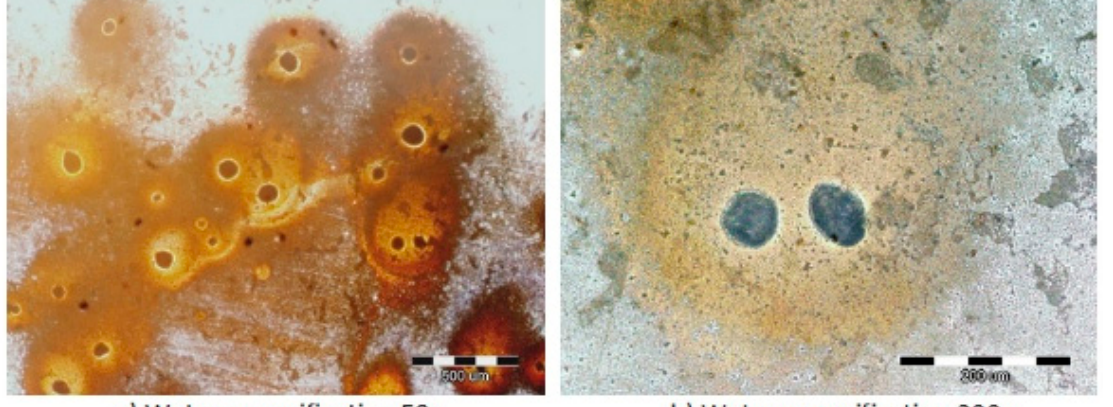
Table 5. EDS analysis of the positions marked as 1, 2, and 3 in Figure 8a.